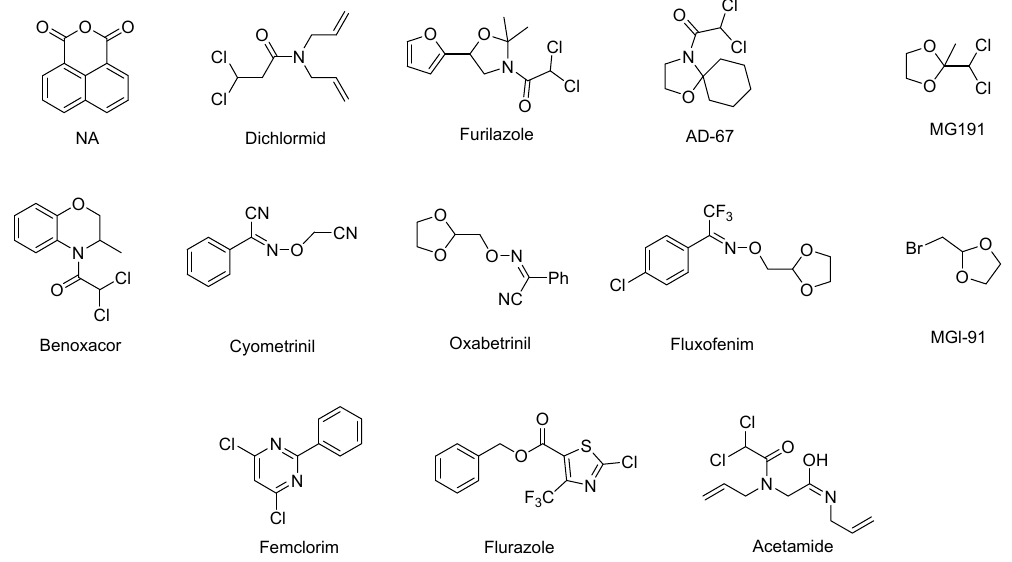
Figure 1. Chemical structures of some commercial herbicide safeners.